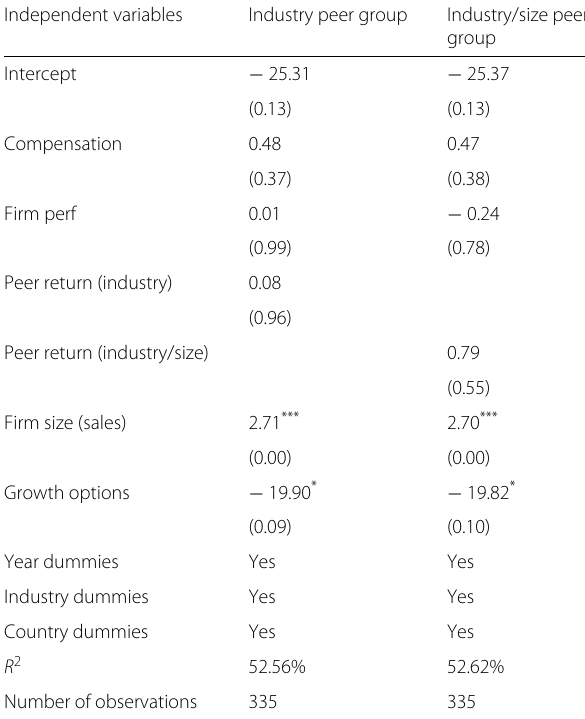
Table 5 Logit regression of RPE usage in executive compensation